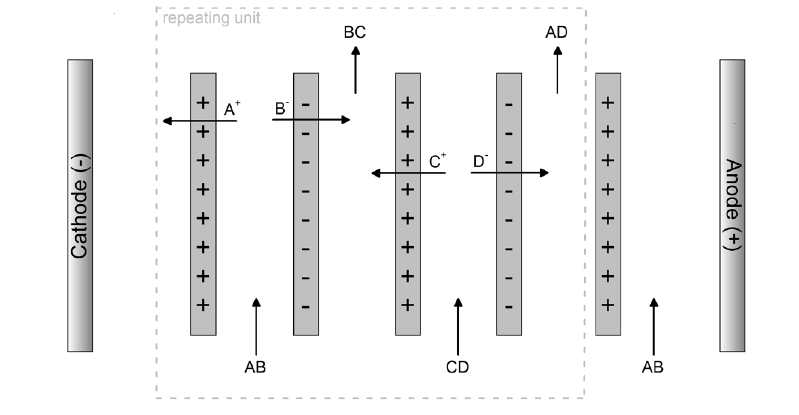
Figure 4: Schematic representation of metathesis-electrodialysis.